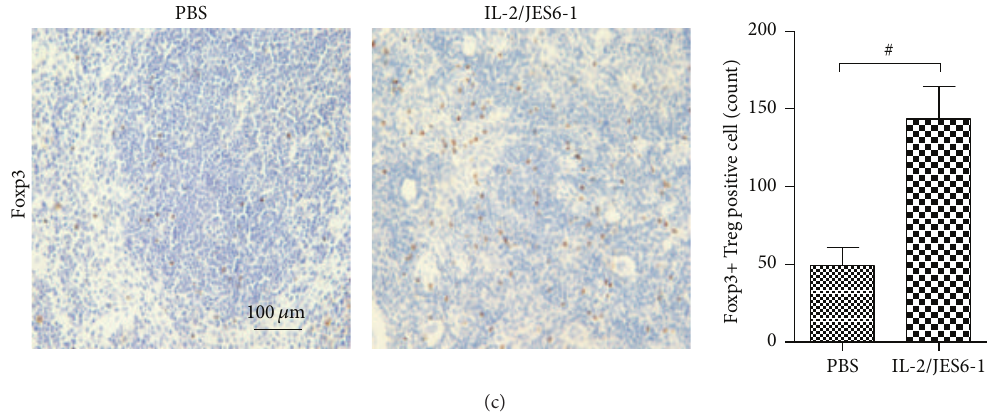
Figure 1: Expansion of CD4+CD25+Foxp3+ Tregs in both spleen and mediastinal lymph nodes (mLNs) after treatment with IL-2/JES6-1 complex invivo .PBSortheIL-2/JES6-1complexwasadministeredintraperitoneallyinmouseforthreeconsecutivedays.CD4+CD25+Foxp3+ Treg cells from splenocytes or mLNs cells were stained and analyzed by flow cytometry on day 5. (a) Representative results of the proportion of CD4+CD25+Foxp3+ Treg cells in the spleen and mLNs analyzed by flow cytometry. (b) The percentage of CD4+CD25+Foxp3+ Treg cells within the CD4+ T cell population was enhanced in both spleen and mLNs in the IL-2/JES6-1 group. (c) The numbers of Foxp3+ T cells in spleen were also increased in the IL-2/JES6-1 group by immunohistochemical staining ( 𝑛 = 6 per group). Original magnification × 200. # 𝑃 < 0.05 versus the PBS